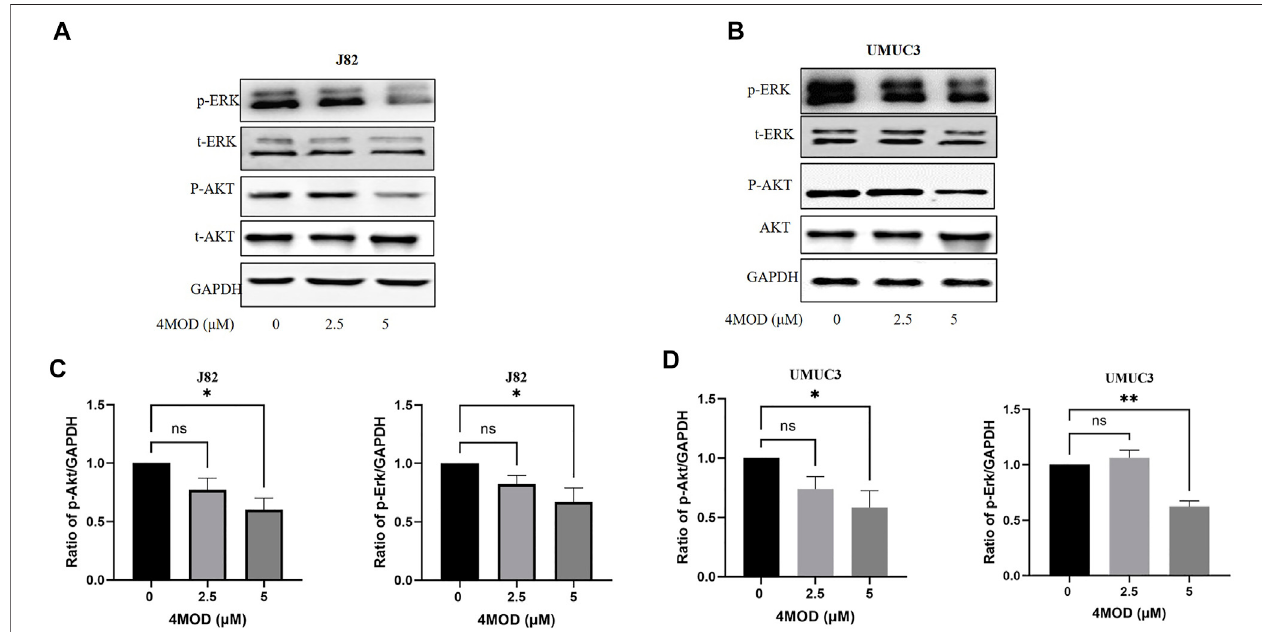
FIGURE 6 | 4MOD inhibits Akt/ERK signaling in BC cells (A – B) The UMUC3 andJ82 cells were treated with 0 – 5.0 μ M 4MOD for 72 h 4MOD or DMSO. Western blot analysis was used to examine total (t) and phosphorylated (p) forms of Akt and Erk, GAPDH was included as a loading control (C-D) Relative levels of phosphorylated Akt, Erk are shown as means ± SD, n (cid:1) 3, ** p < 0.01, * p <